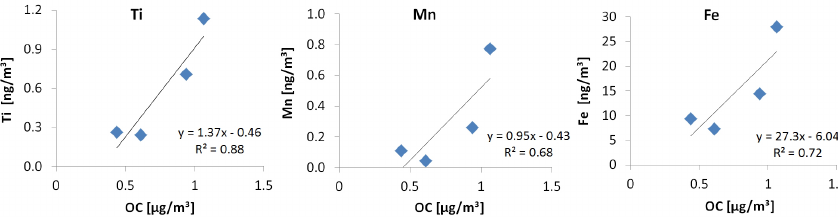
Figure 3. PM 3 . 5 scatter plots of Ti, Mn, and Fe against OC at the upwind